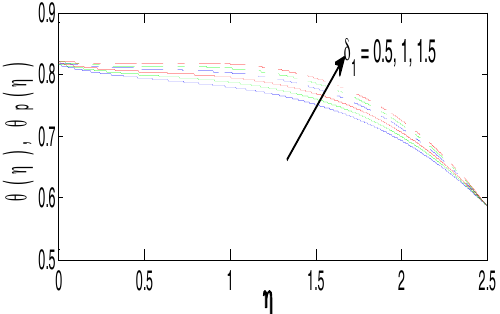
Appl. Sci. 2019 , 9 , x FOR PEER REVIEW Figure 10. Impact of δ 1 on temperature profile θ and θ p of fluid with dusty particles. Figure 10. Impact of 1  on temperature profile  and Figure 10. Impact of 1  on temperature profile  and Figure 10. Impact of 1  on temperature profile  and